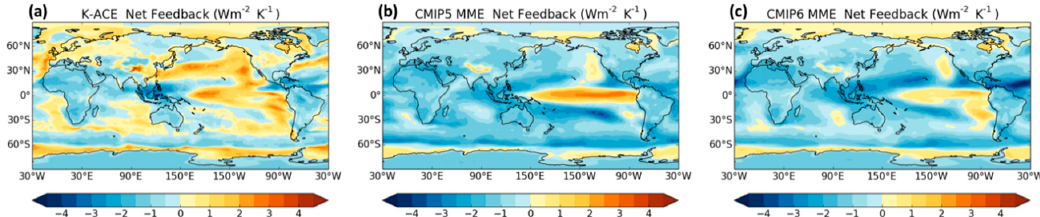
Figure 4. Global mean net radiative feedback components in Wm − 2 K − 1 derived from ( a ) K-ACE, ( b ) the CMIP5 multi-model, and ( c ) the CMIP6 multi-model ensemble. These patterns are determined from the slope of the linear regression of the change in local radiative flux against global mean air temperature change over the 150 years in the abrupt experiment.